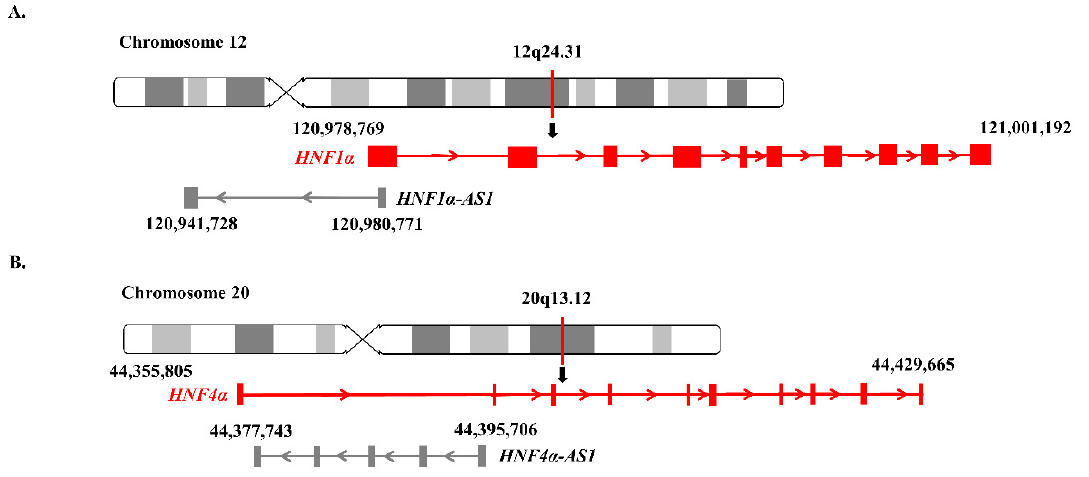
Figure 3. Genomic locations of HNF1 α , HNF1 α -AS1, HNF4 α , and HNF4 α -AS1 : ( A ) locations of HNF1 α and HNF1 α -AS1 on human chromosome 12; and ( B ) locations of HNF4 α and HNF4 α -AS1 on human chromosome 20.